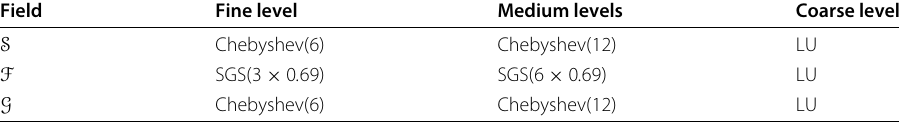
Table3 Settings for multigrid hierarchies embedded in the hybrid preconditioner